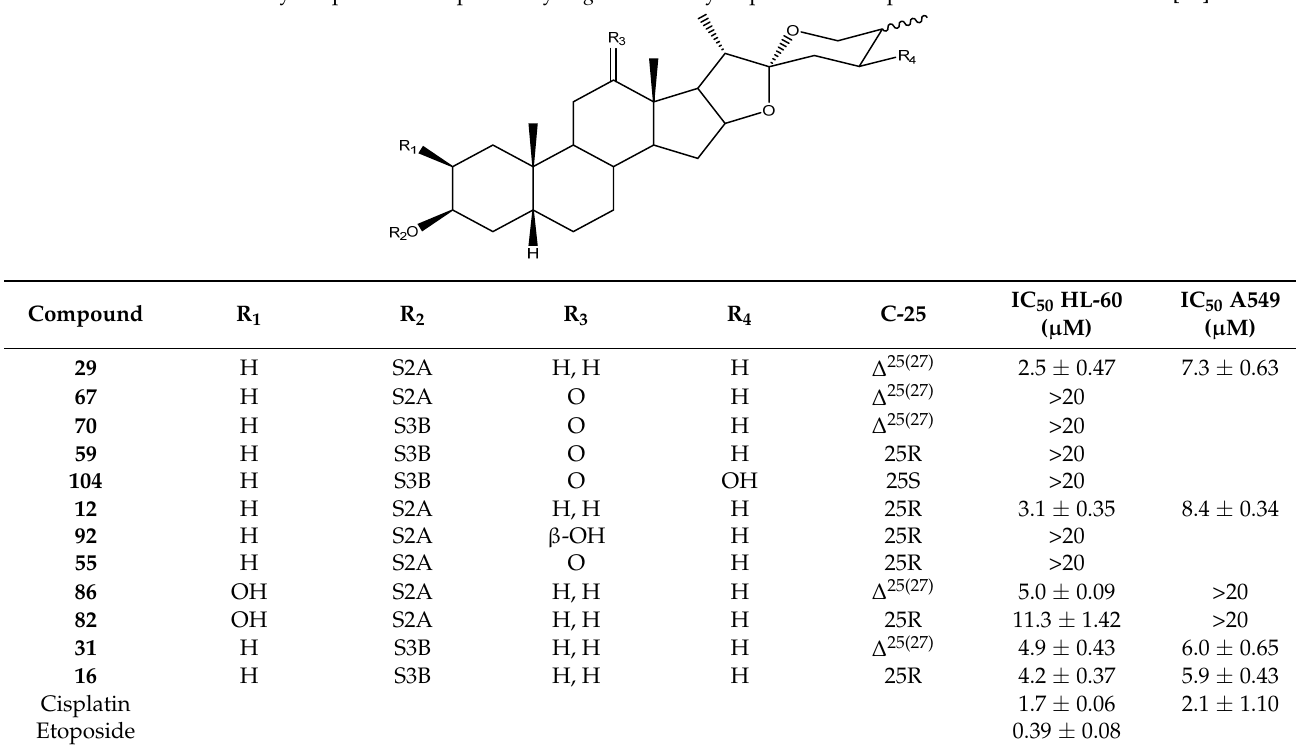
Molecules 2021 , 26 , x FOR PEER REVIEW